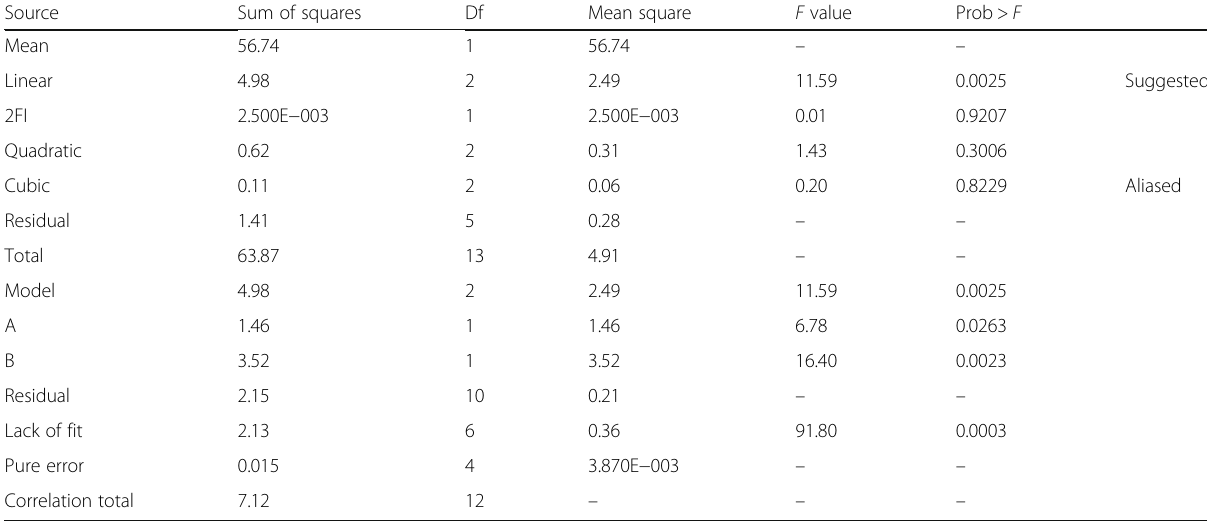
Table 3 Sequential model sum of squares and ANOVA for response surface linear model for essential oil extraction Source